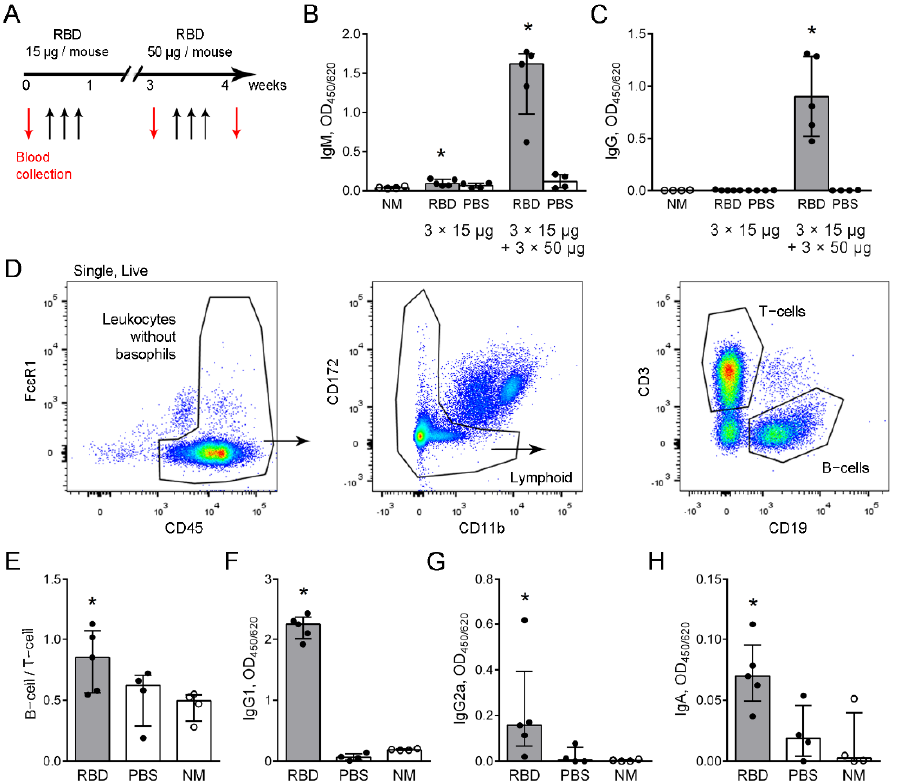
Figure 1. RBD–specific antibody induction. ( A ) The scheme of i.p. injections of RBD to mice (black arrows) and the time points of blood collection (red arrows). ( B , C ) The levels of IgM ( B ), serum dilution 1:100, and IgG ( C ), serum dilution 1:1000, two weeks after the last 15 µ g RBD injection (3 × 15 µ g) and a week after the last 50 µ g RBD injection (3 × 15 µ g + 3 × 50 µ g). ( D ) The strategy of T − and B − cells detection in peripheral blood of the mice. ( E ) The ratio of B − cells to T − cells a week after the last RBD injection. ( F – H ) The levels of periphery blood IgG1 ( F ), IgG2a ( G ) serum dilution 1:1000, and IgA ( H ), serum dilution 1:100, in mice that were injected with RBD (gray bars, black circles) or in the control mice that were injected with PBS (open bars, black circles), and in the intact mice (NM, open bars, open circles) a week after the last RBD injection. The representative data are shown ( n ≥ 4 mice per group). A significant difference between the indicated group and the intact mice was detected using Mann–Whitney test *: p ≤ 0.05 .